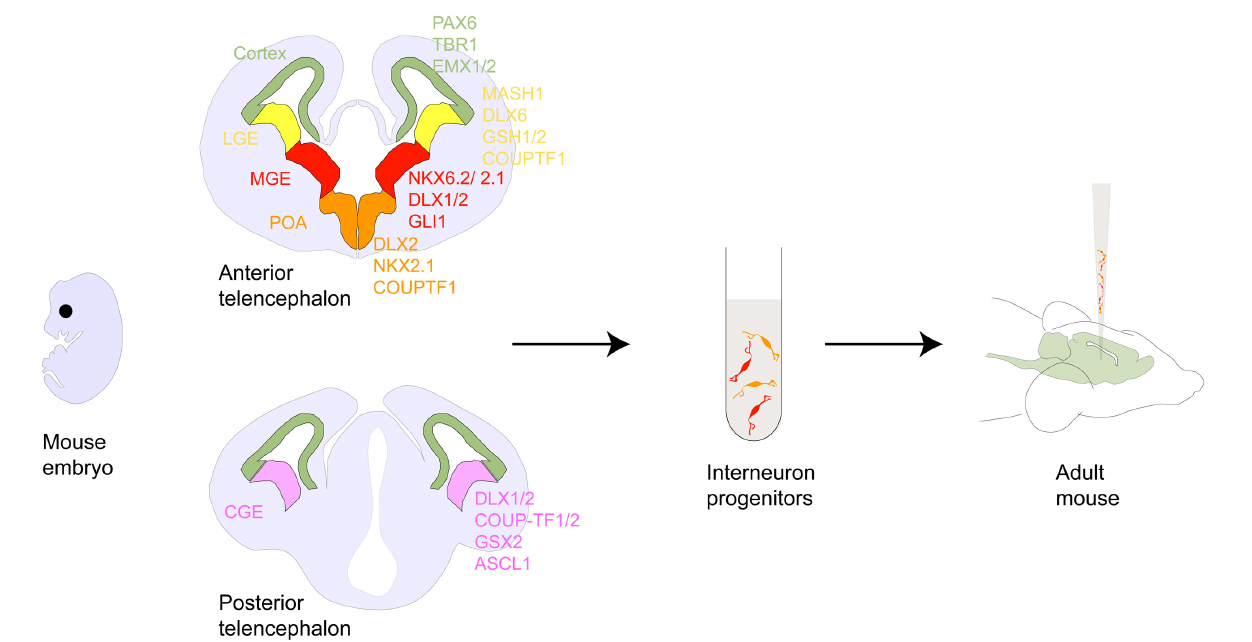
FIGURE 1 | Interneuron development within the forebrain. Schematic showing coronal sections of the rodent anterior and posterior telencephalon. Shown are the pallial and subpallial neurogeneic niches and their gene expression patterns. Following the discovery of tangentially migrating neurons in the developing cortex (Walsh and Cepko, 1988, 1993) several cell lineage studies demonstrated that many of these neurons originated in the ventral telencephalic ganglionic eminences and the POA and ultimately matured into GABAergic interneurons. For example, ablation of the embryonic ventral telecephalon or mutation of the homeodomain transcription factor gene Dlx1/2 heavily expressed in this region results in a dramatic loss of neocortical GABAergic neuron populations (Anderson et al., 1997). Ventral fate inducing sonic hedgehog(SHH) signaling has been shown to specify PV and SST expressing interneuron differentiation from ventral telencephalic progenitors in culture and in vivo (Xu et al., 2010; Tyson et al., 2015). Several other homeobox genes such as Mash1 (Casarosa et al., 1999), Nkx2.1 (Sussel et al., 1999), Lhx6 (Liodis et al., 2007), and FGFR (Gutin et al., 2006), as well as guidance cues such as the chemorepulsive semaphorin/neuropilin (Marín et al., 2001) and chemoattractive neuregulin-1/ErbB4 (Flames et al., 2004) interactions have been shown to be critical for proper direction and selection of GABAergic cell identity, subtype and migration. Genetic fate mapping of transplanted embryonic cells in cultures or in utero has revealed that MGE gives rise to PV- and SST-, while CGE gives rise to CR-, VIP- and Reelin-expressing interneurons, with each cell group having a distinct spatio-temporal origin (Nery et al., 2002; Xu et al., 2004; Butt et al., 2005; Miyoshi et al., 2010; Petros et al., 2015). In addition, the POA has been shown to be the origin of at least 10 percent of GABAergic interneurons comprising of PV-, SST- and a small percentage of VIP-, NOS-, and CR-expressing interneurons (Gelman et al., 2011). Abbreviations: LGE, MGE, CGE (lateral, medial, caudal ganglionic eminence); POA (preoptic area); CB (cabindin), CR (calretinin), PV (parvalbumin), SST (somatostatin), NPY (neuropeptide Y), RLN (reelin), NOS (nitrous oxide) expressing